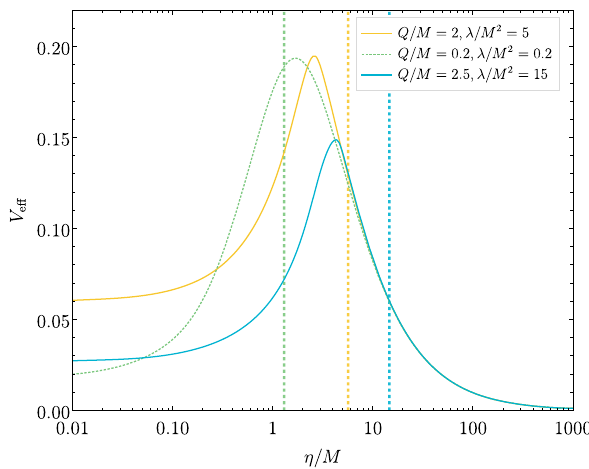
Fig. 39 Effectivepotential V eff formasslessparticlesandlight( κ = 0): coupling (iii) with equator at η = 0 and throat at the vertical dashed line